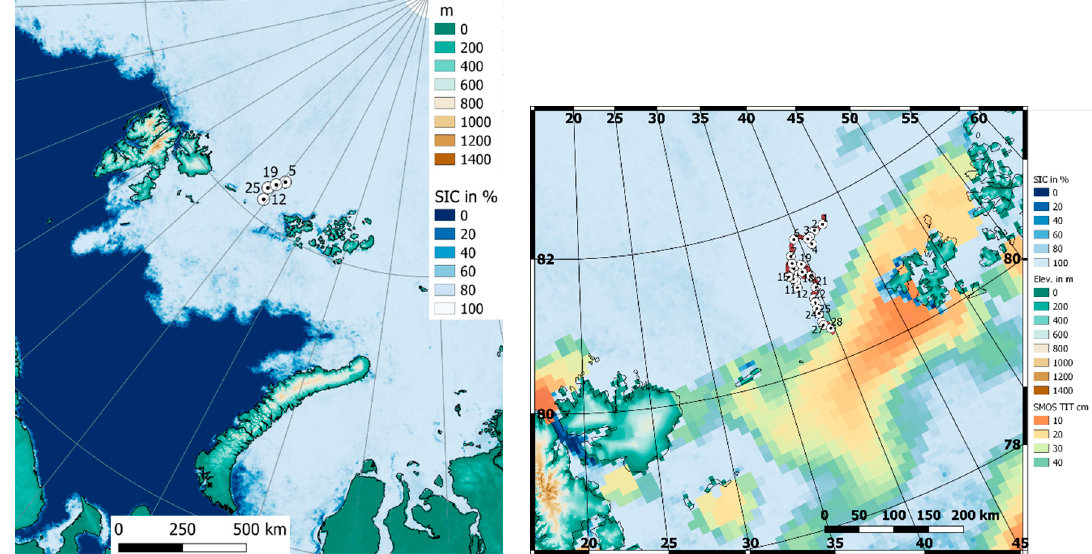
Figure 1. Left : Model domain of the COSMO-CLM (CCLM) model with 5 km resolution with topography and sea ice concentration for 15 April 2019 and ship positions for 5, 12, 19 and 25 April 2019. Right : subsection of the model domain with daily ship positions during the drift (numbers are the days of April) and sea ice conditions for 15 April 2019. In addition to sea ice concentration, thin ‐ ice thickness (TIT) from Soil Moisture and Ocean Salinity (SMOS) data are shown.